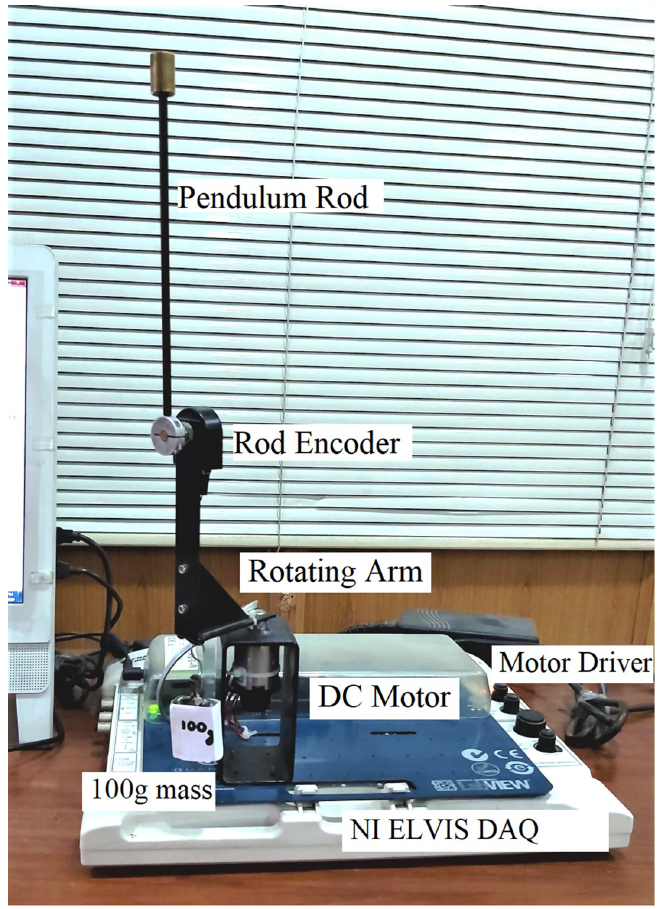
Fig 5. QNET Rotary Inverted Pendulum